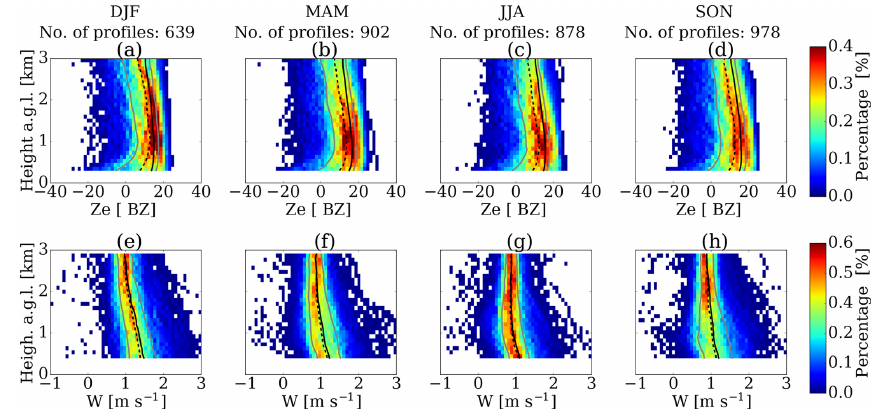
Figure 7. Frequency by altitude diagram for Ze (a, b, c) and W (e, f, g) values observed at DDU during DJF (a, e) , MAM (b, f) , JJA (c, g) , and SON (d, h) of surface precipitation. Solid black and dashed black lines represent the average and median vertical profiles of Ze and W , respectively. Grey lines correspond to the 20% and 80% quantiles of the vertical profiles.